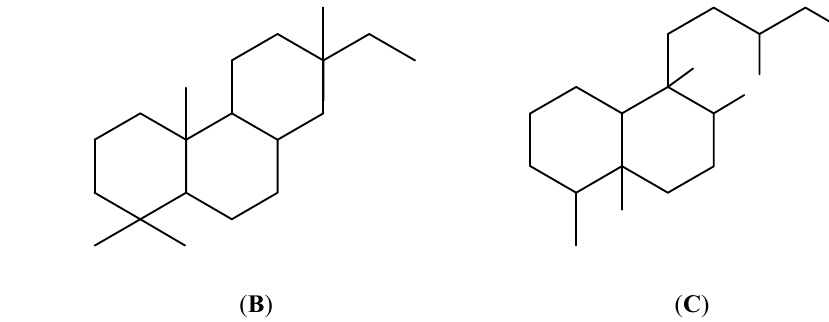
Figure 1. The structure of abietane ( A ), pimarane ( B ) and clerodane ( C ) diterpenoids.